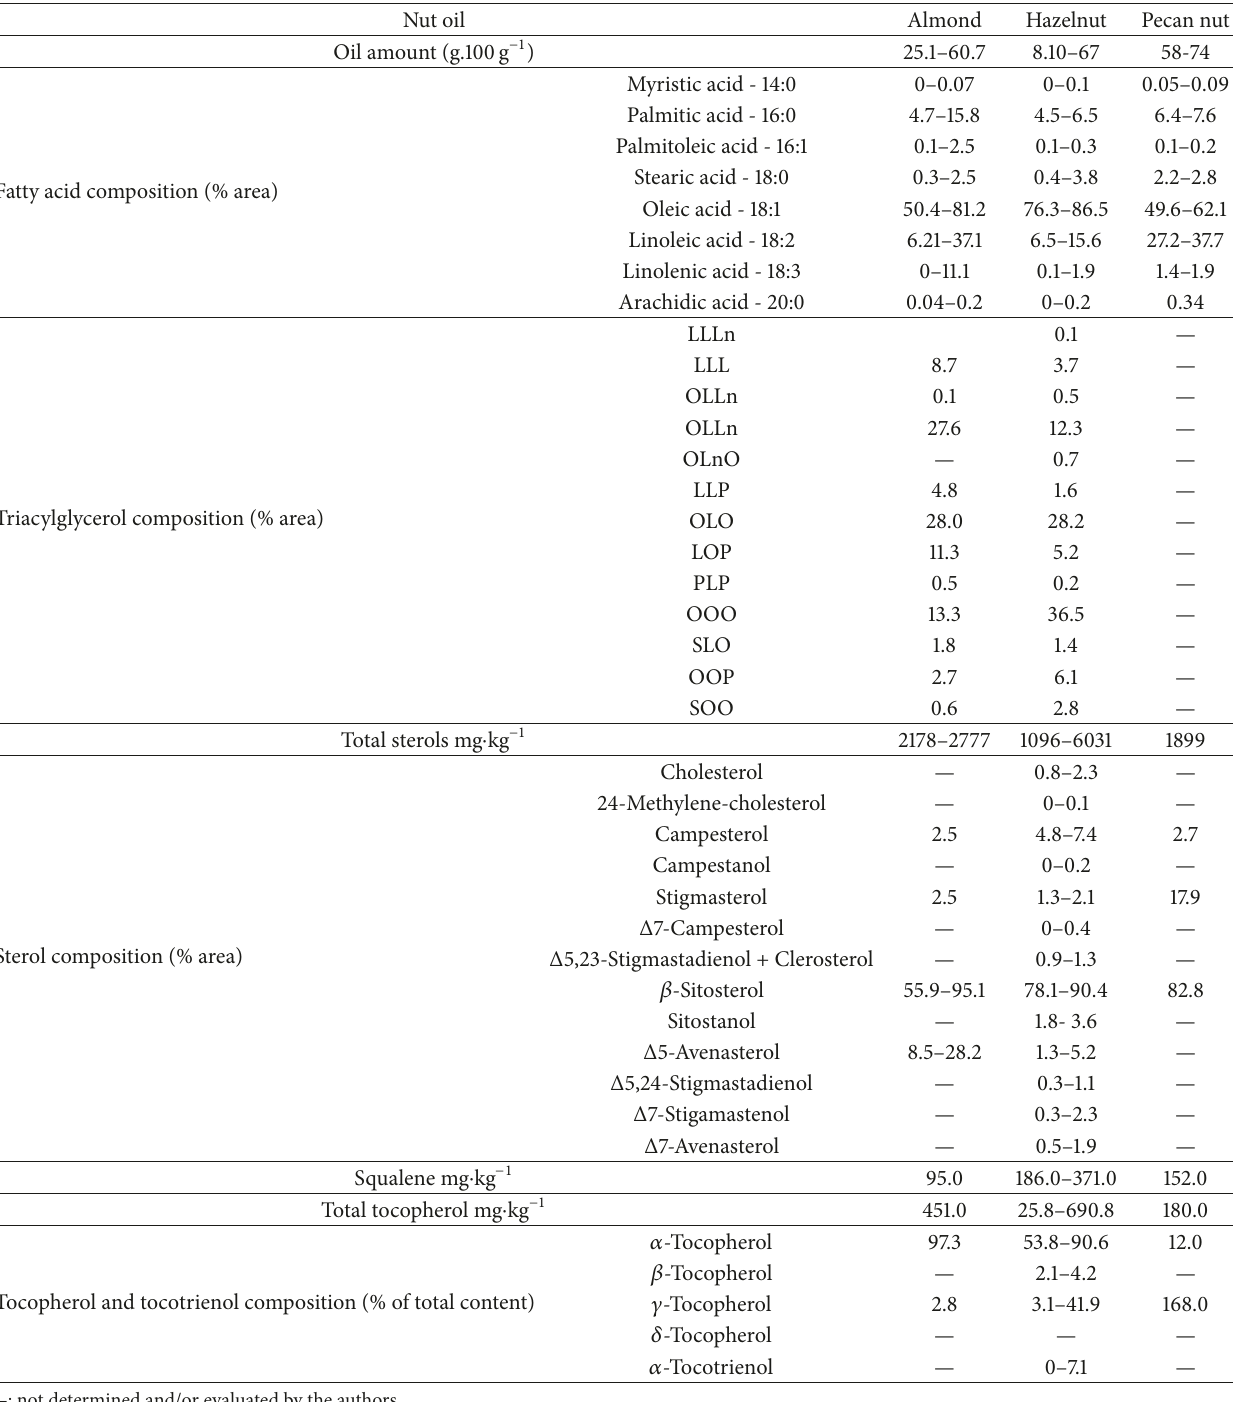
Table 1: Bibliographic information on the chemical composition of almond, hazelnut, and pecan nut oils. References [1–3, 5–8, 10,